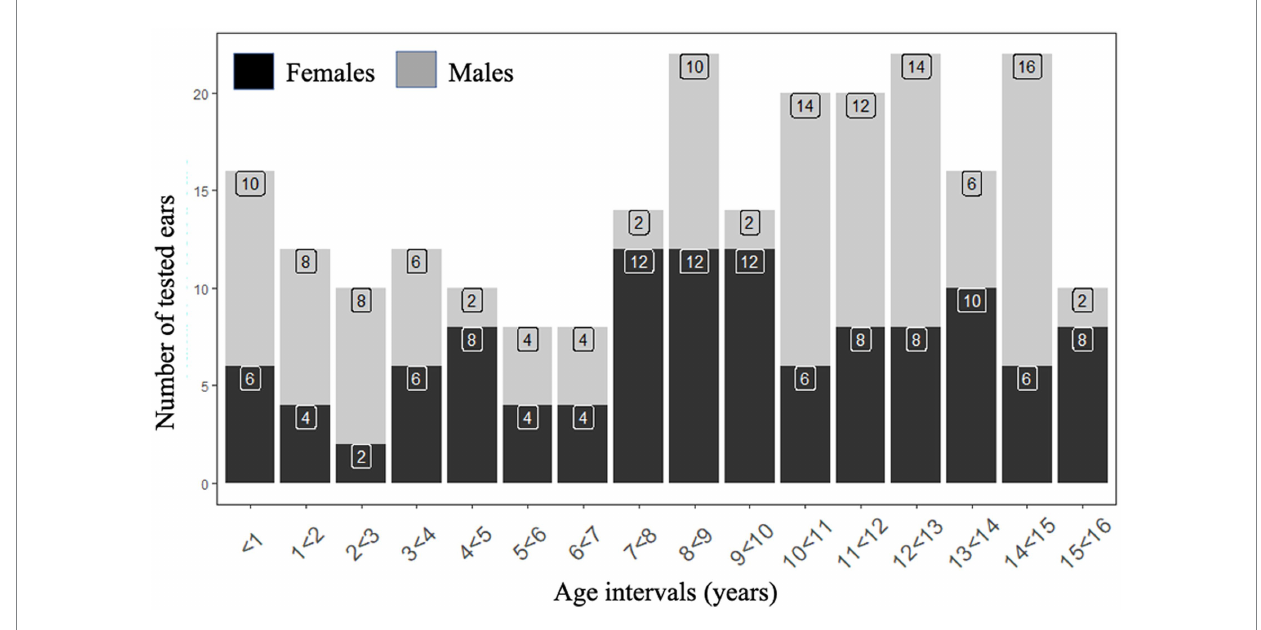
FIGURE 1 Age and gender distribution of the population of healthy children and adults.